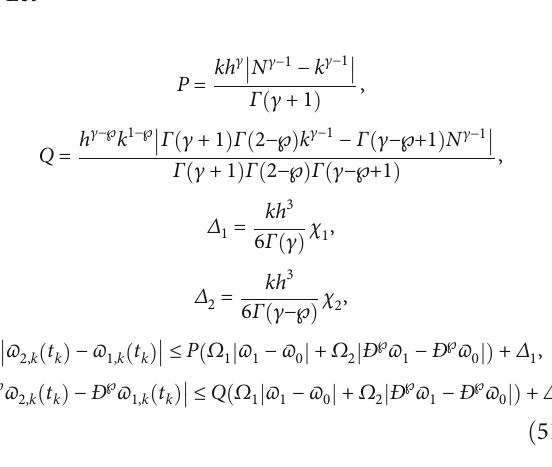
Table 2: Error for the numerical solution of Example